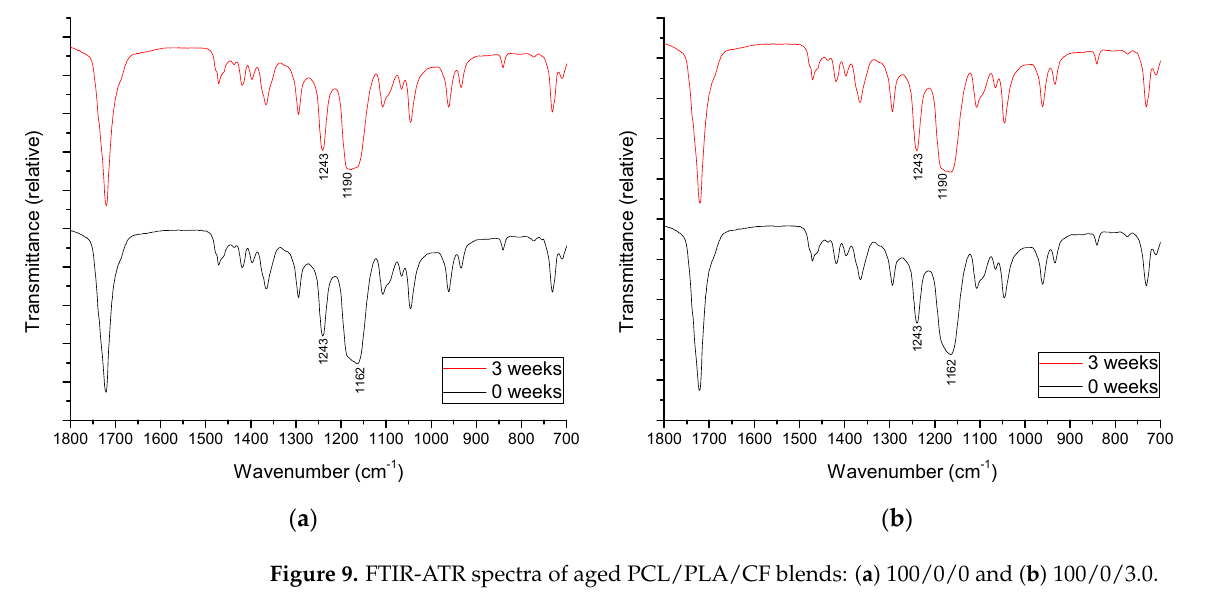
( b ) Figure 8. Hardness of aged PCL/PCL/CF blends: ( a ) 100/0/0, 100/0/0.5, 100/0/3.0 and ( b ) 70/30/0, 70/30/0.5, 70/30/3.0.